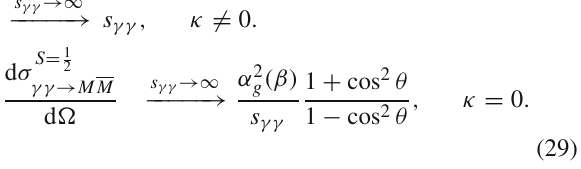
is shown in Fig. 11. The exchange energy in the centre-of- mass frame is k π k π = s qq